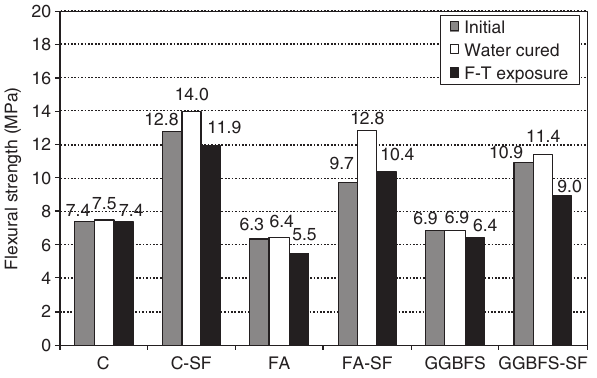
Figure 7 Initial, in water, and residual flexural